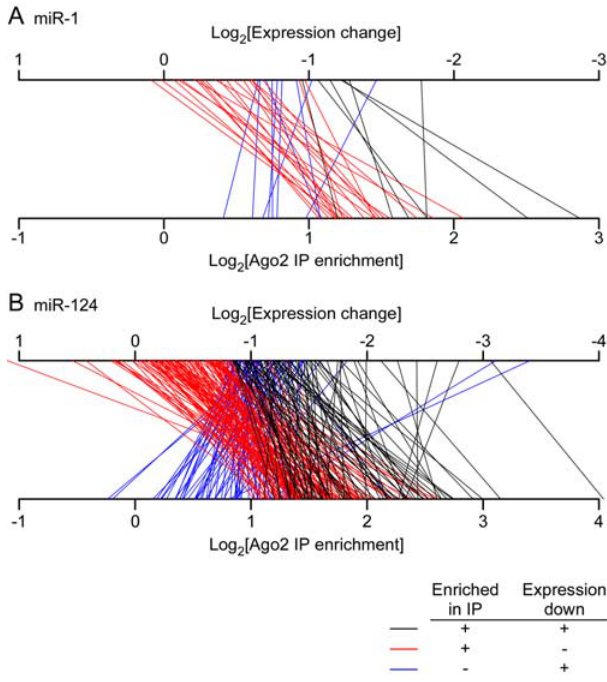
Figure 5. Relationship between overrepresentation in Ago2 IP and changes in mRNA levels due to miR-1 and miR-124. (A) Lines connect the log 2 of the average Ago2 IP enrichment value (bottom axis) to the log 2 of the average mRNA expression change (top axis) for three groups of mRNAs from miR-1 experiments. This analysis contains only mRNAs with 7mer seed matches in their 3 9 -UTRs. Black lines correspond to mRNAs that were Ago2 IP targets (1% local FDR) and decreased significantly at the mRNA level (10% local FDR); seven mRNAs are in this group. Red lines correspond to mRNAs that were Ago2 IP targets but did not decrease significantly at the mRNA level; nevertheless, 20 of 22 mRNAs in this group are downregulated (log 2 change , 0) at the mRNA level (P , 10 2 5 , one-way binomial test). Blue lines correspond to mRNAs that decreased significantly at the mRNA level, but were not Ago2 IP targets; all 9 mRNAs in this group are overrepresented (log 2 enrichment . 0) in Ago2 IPs (P=0.0006). (B) Same as in (A) except for mRNAs from miR-124 experiments. 82 mRNAs are in the black group. 109/121 mRNAs in the red group are downregulated at the mRNA level (P , 10 2 15 ); and 63/65 mRNAs in the blue group are overrepresented in Ago2 IPs (P , 10 2 15 ). overrepresented in Ago2 IPs, but decrease significantly at the mRNA level (Figure 5, blue lines). To enrich for the highest confidence targets, we focused on mRNAs with a 7mer seed match in their 3 9 -UTRs.